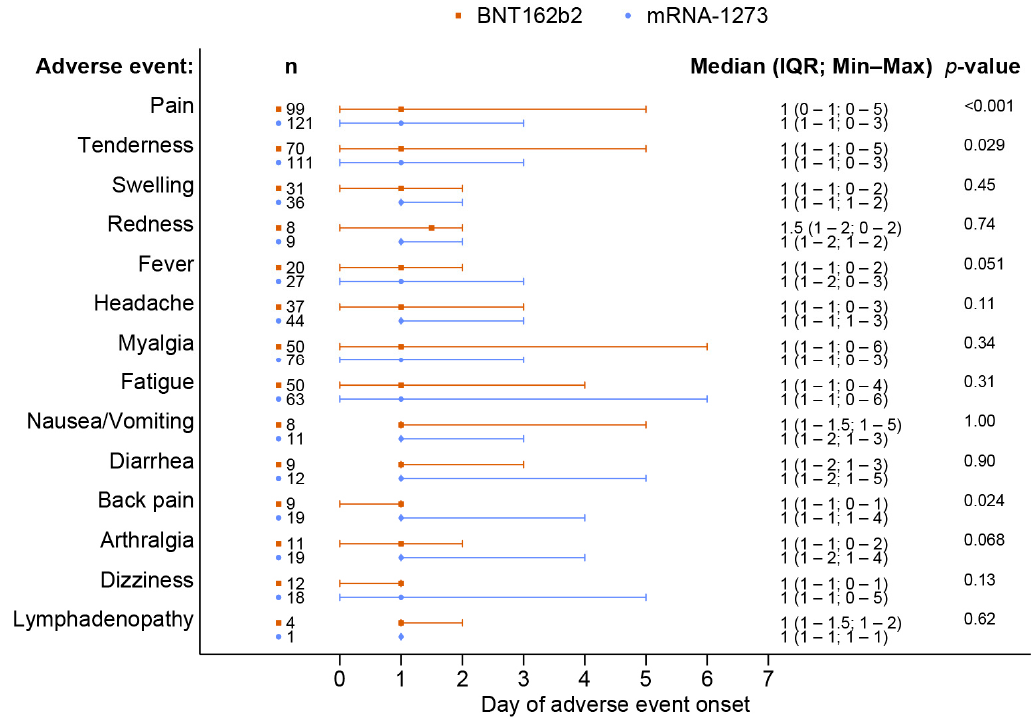
Figure 2. Onset of adverse events following the booster dose with the BNT162b2 as compared to the mRNA-1273 vaccine.